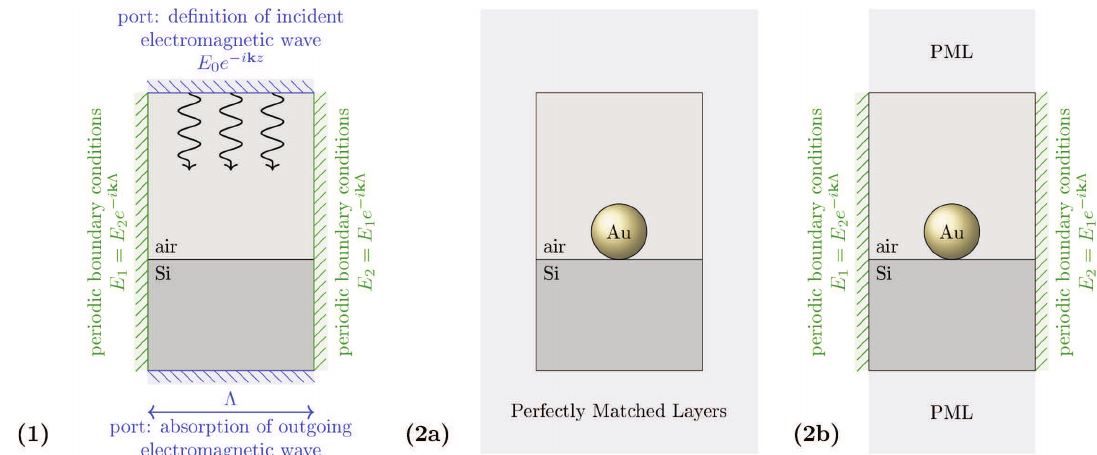
Figure 5. The scheme of the unit cell of numerical model for Comsol. ( 1 ) The first step of calculations—the evaluation of the background electric field as the reference field distribution for the second step. ( 2a ) The second step for the single particle model (none periodic conditions are imposed). ( 2b ) The second step for the model of metallic nanoparticles (MNPs) array with the periodic Floquet conditions